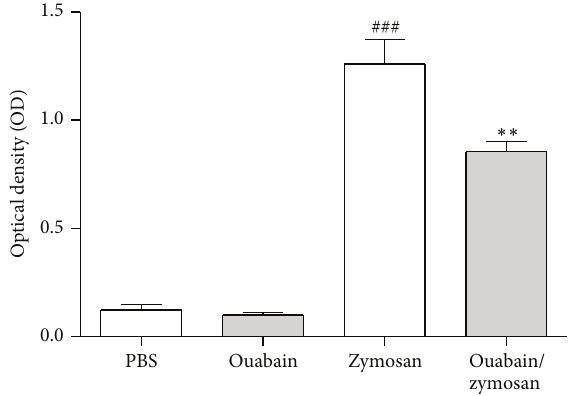
Figure 1: Ouabain decreases plasma extravasation induced by zymosan. Swiss mice ( 𝑛 = 6 ) were pretreated with 0.56 mg/kg of ouabain (i.p.) or PBS for 3 consecutive days. One hour after the last dose of treatment, animals were stimulated with zymosan (i.p.). The results were expressed as absorbance for the Evans blue dye present in the peritoneal exudate. Results were expressed as mean ± SEM and analyzed by Graphpad Prism using ANOVA with Tukey’s posttest, where all groups were compared. ### 𝑃 < 0.001 versus PBS group and ∗∗ 𝑃 < 0.01 versus zymosan group.